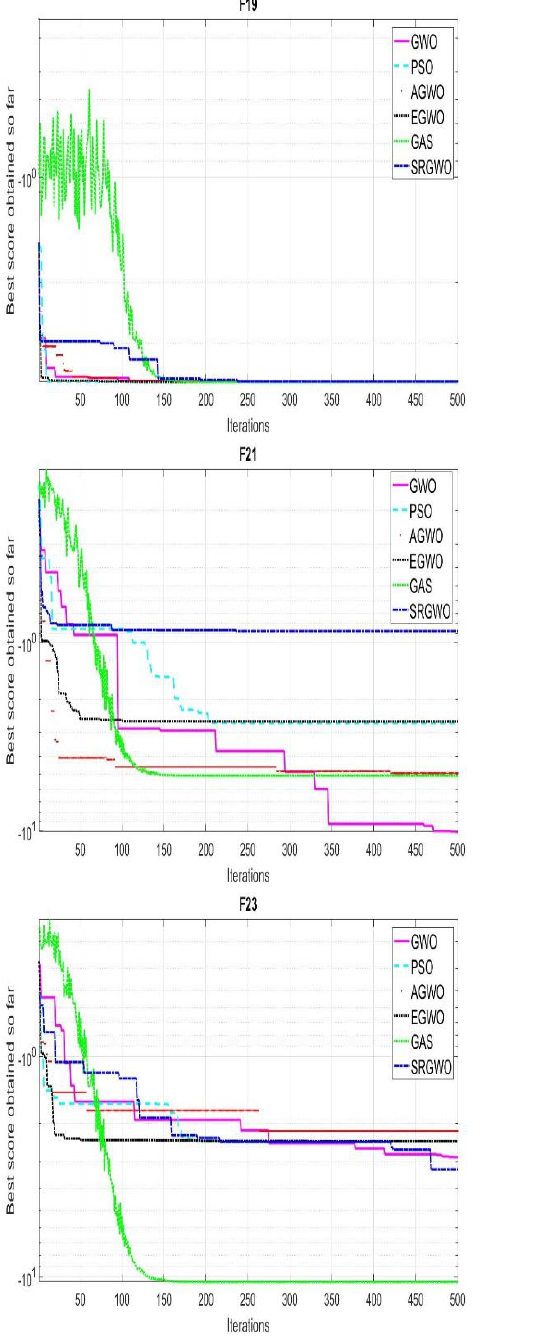
Figure 2. Convergence curves of the GWO, PSO, AGWO, EGWO, GSA, and SRGWO algorithms for twenty-three benchmark